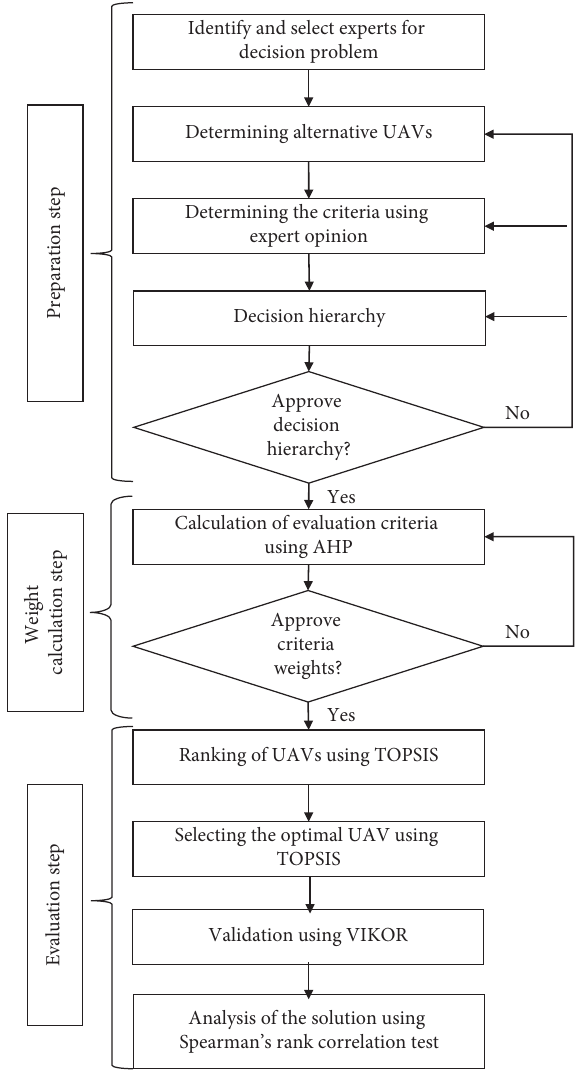
Figure 1: The schematic diagram for